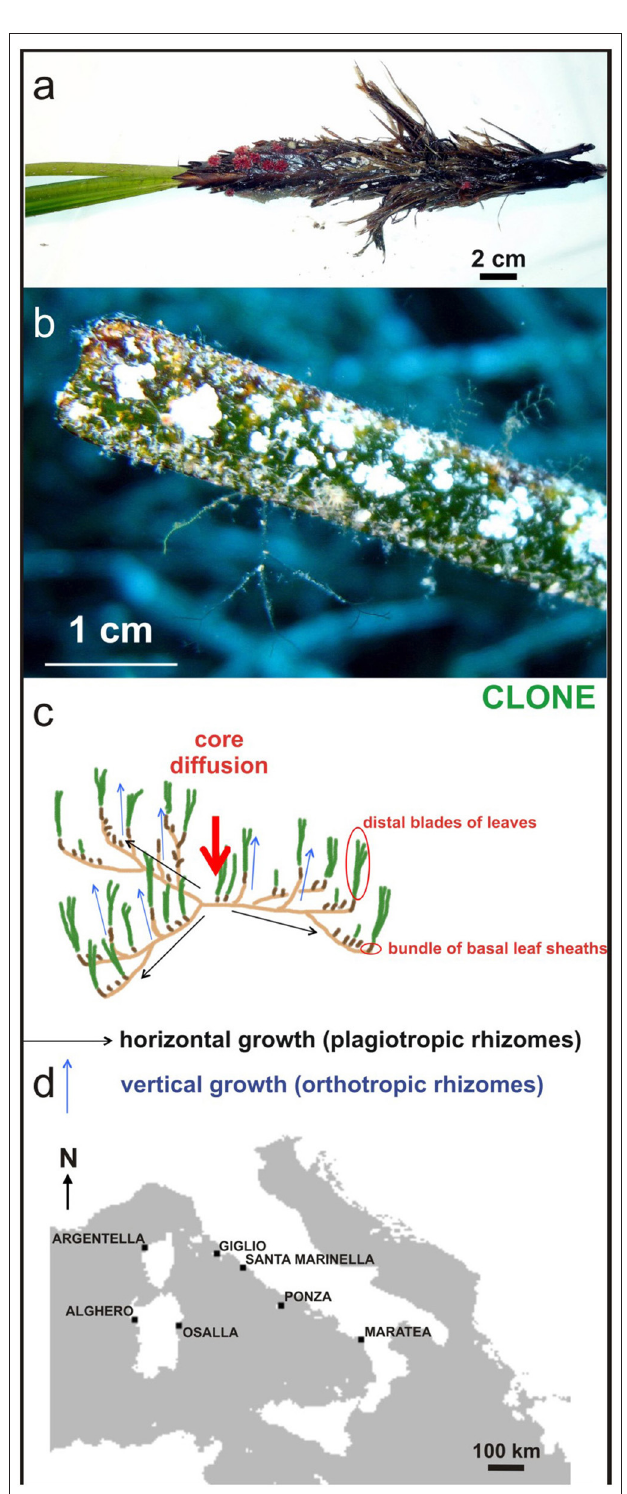
FIGURE 1 | (A) Biota dwelling vertical rhizome ( Miniacina miniacea ) and (B) leaves as epiphytic forms; (C) clonal growth reproductive strategy involves the development of modular units, knowns as ramets, through horizontal growth of the rhizome, genetically identical to the parent plant, the genet; (D) Location map of sampling sites for measurement of seagrass carbonate